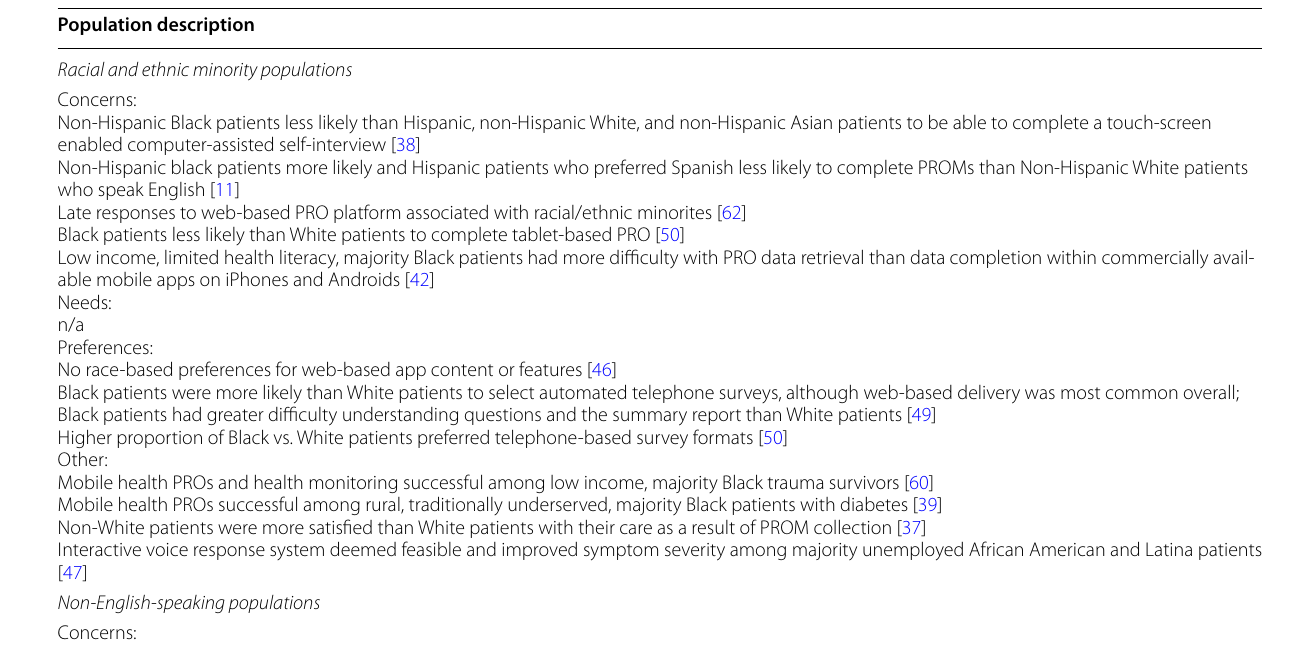
Table 4 Overall concerns, needs, and preferences of populations identified in the review Population description Racial and ethnic minority